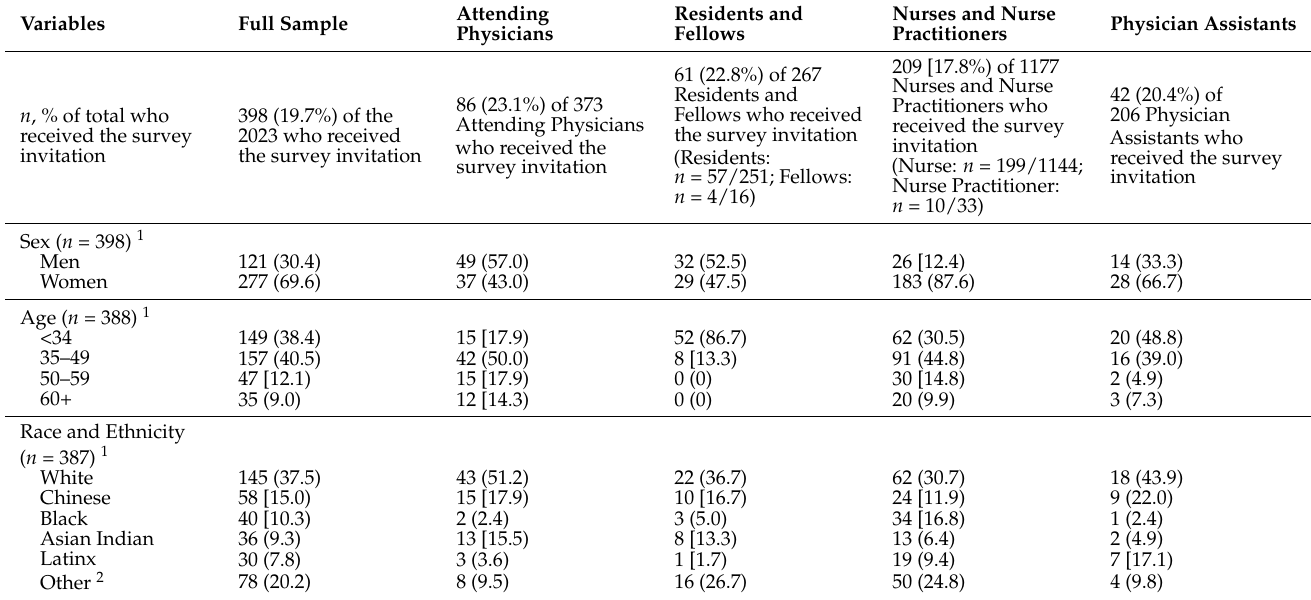
Table 1. Initial Assessment: Participant characteristics for full sample and by professional